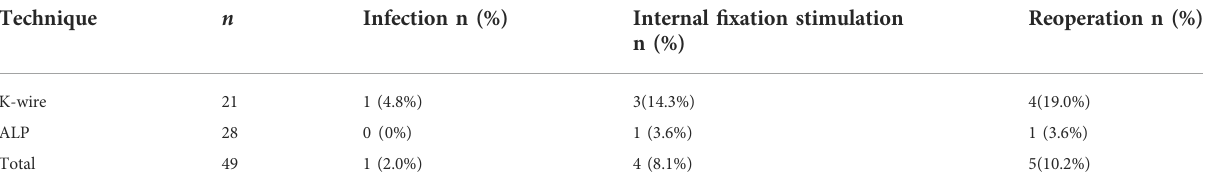
TABLE 4 Postoperative complications according to surgical